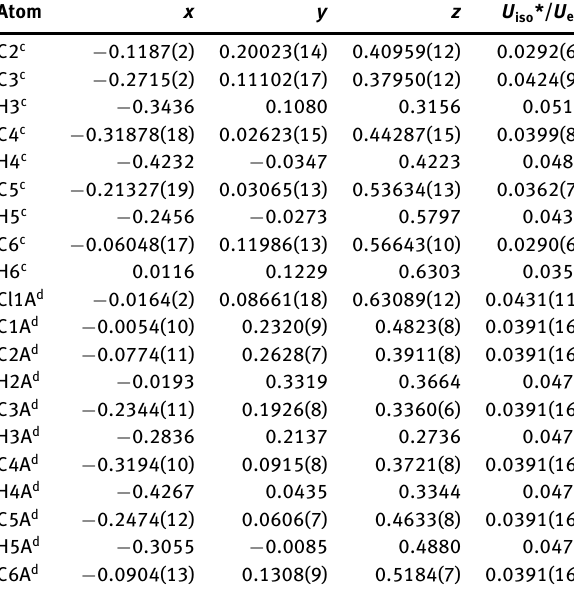
Table 2: Fractional atomic coordinates and isotropic or equivalent isotropic displacement parameters (Å 2